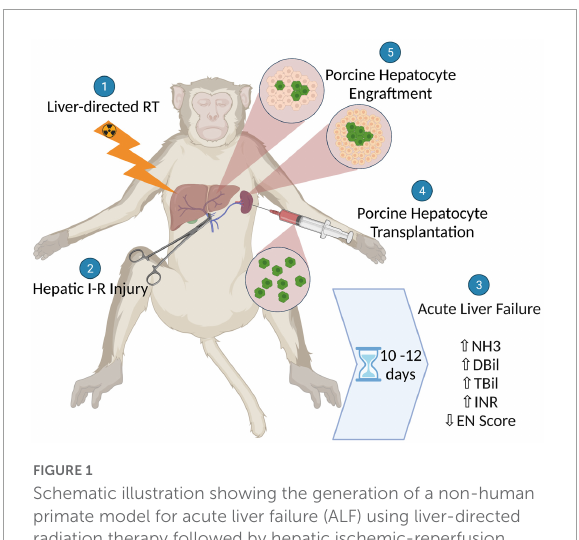
FIGURE1 Schematic illustration showing the generation of a non-human primate model for acute liver failure (ALF) using liver-directed radiation therapy followed by hepatic ischemic-reperfusion injury and the subsequent assessment of xenogeneic hepatocyte transplantation as a potential therapy for